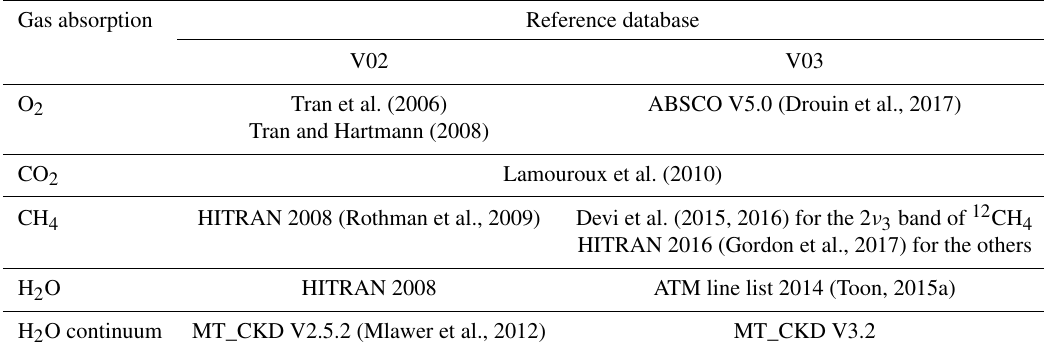
Table 1. Summary of the optical parameter updates.